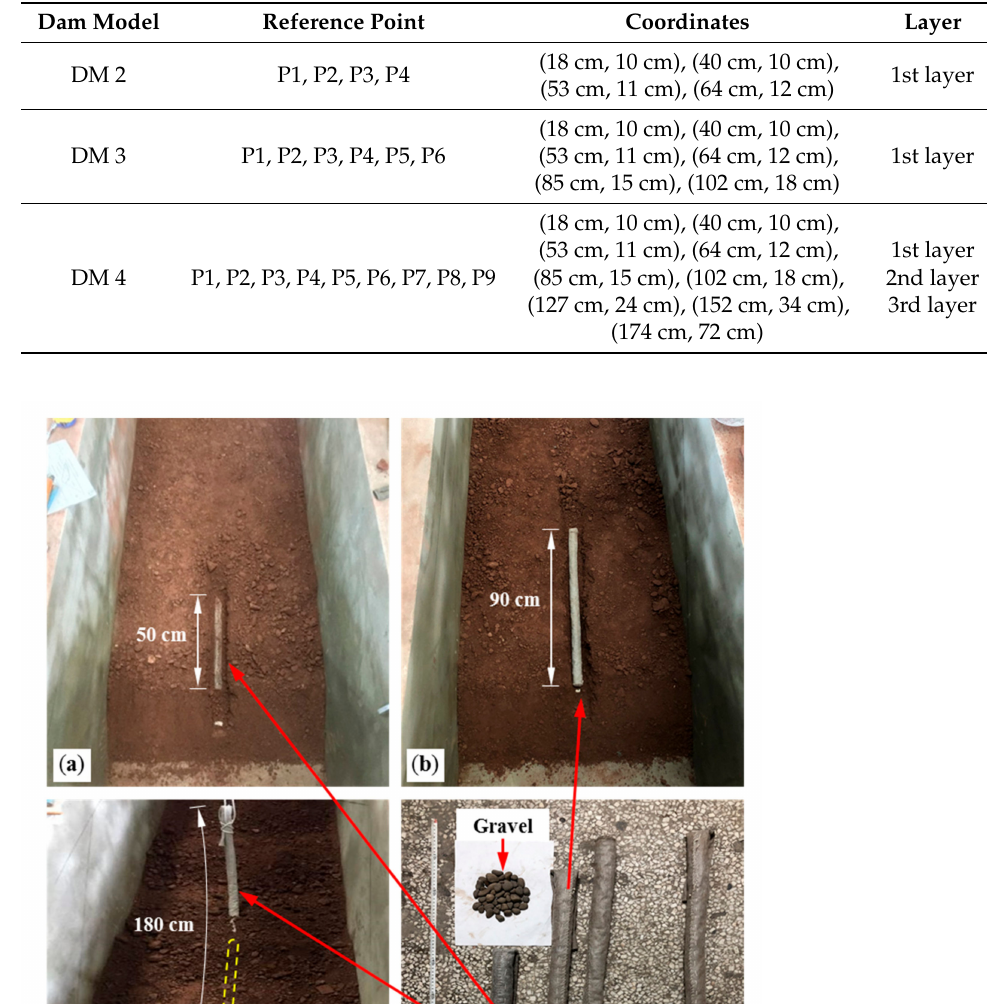
Table 1. Coordinates of the reference points.